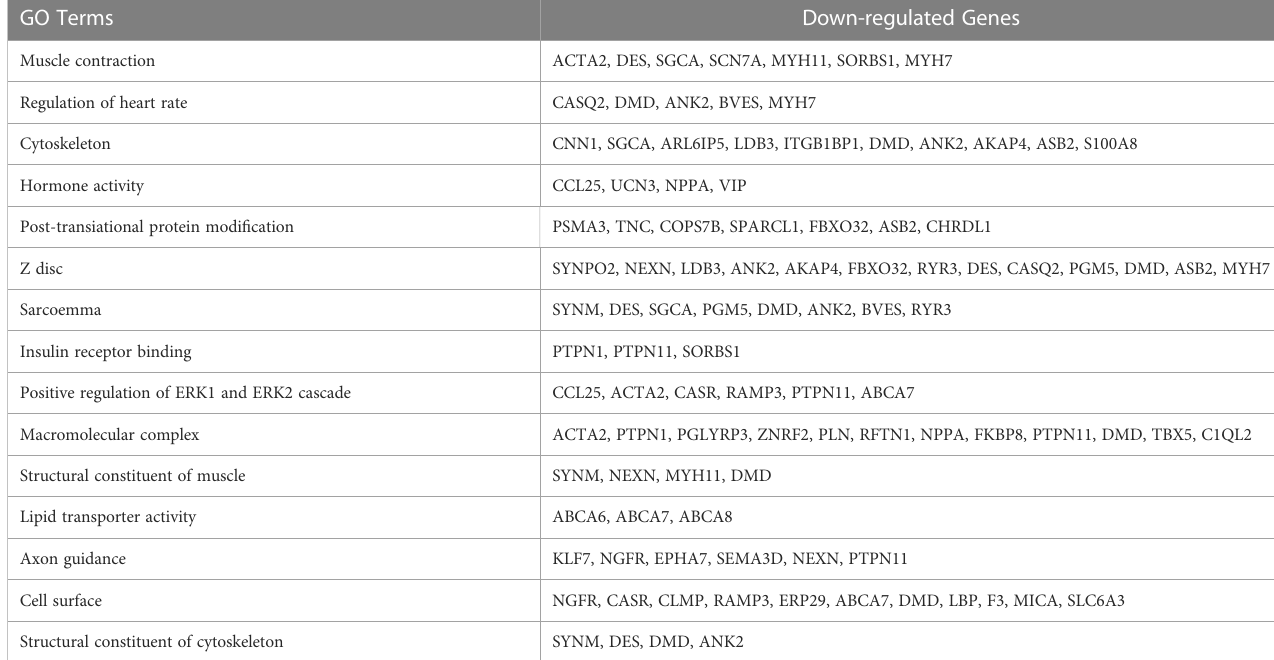
TABLE 2 Down-regulated differentially expressed genes in biological process.